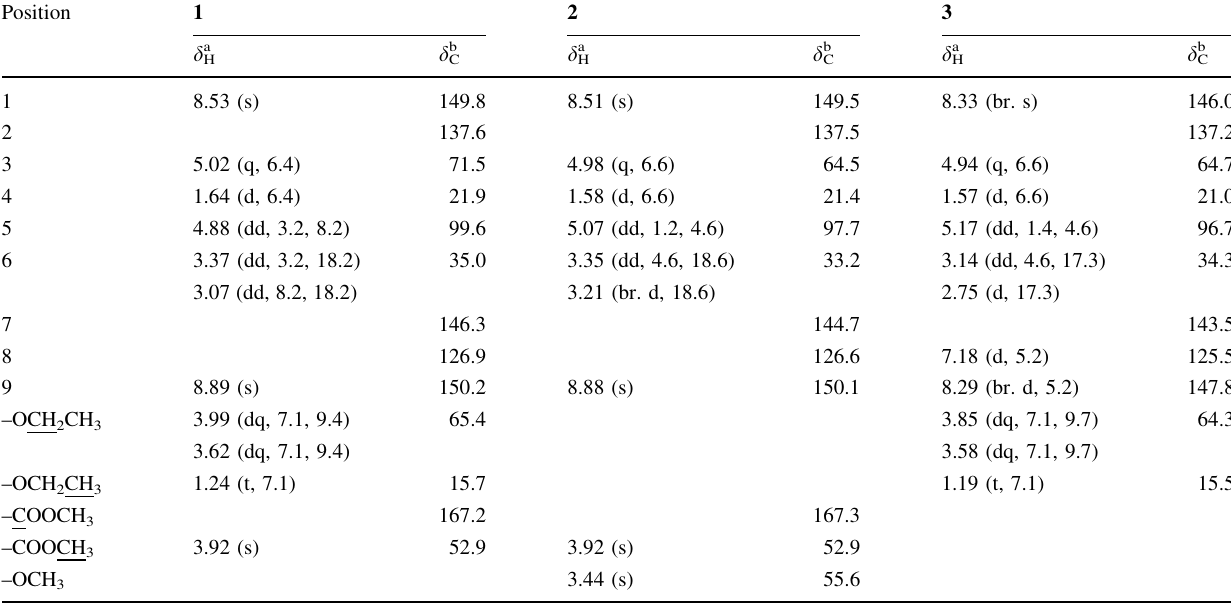
Table 1 1 H and 13 C NMR spectroscopic data of 1 – 3 ( d in ppm, J in Hz)